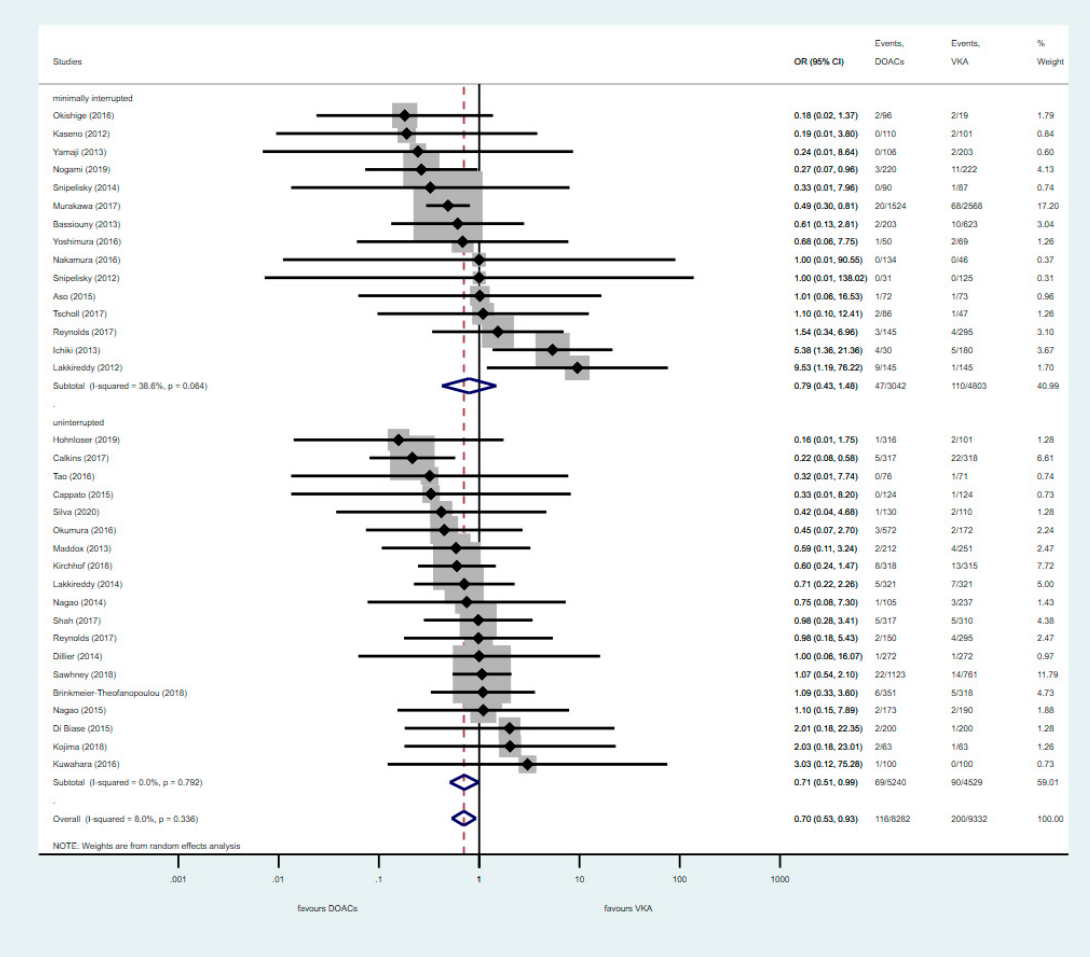
Figure 3. Primary safety outcome of major bleeding with uninterrupted or minimally interrupted DOAC strategies vs. VKA. CI: Confidence Interval; OR: Odds Ratio; DOAC: Direct Oral Anticoagulants; VKA: vitamin K antagonist. The diamond defines the overall result of each given group, the dotted red line is there to graphically show the overall results of the groups